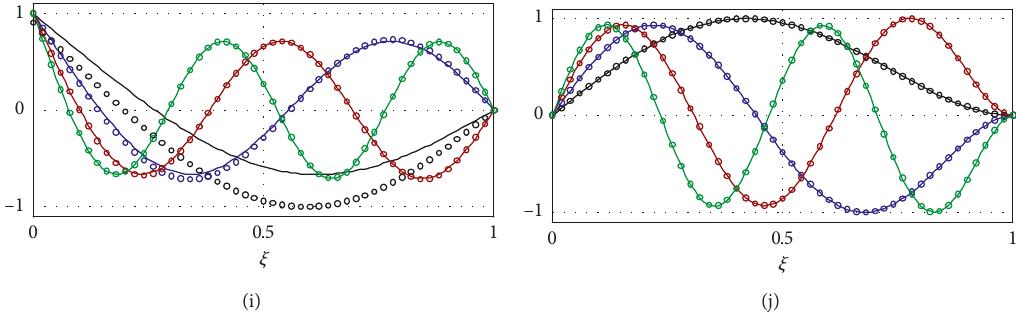
Figure 3: First four mode shapes for ten degenerate cases with a static Winkler foundation (solid line) and with a movable Winkler foundation (circle) when κ 100: (a) Sl-Fi, (b) Fr-Sl, (c) Fr-Fi, (d) Pi-Sl, (e) Sl-Sl, (f) Pi-Pi, (g) Fr-Fr, (h) Fi-Fi, (i) Fr-Pi, and (j) Pi-Fi. Mode (cid:31) shapes of rigid-body vibration are omitted for cases of Fr-Fr and Fr-Pi.